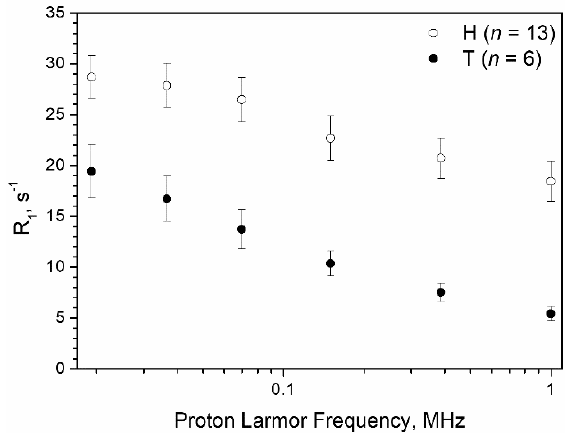
Figure 2. Comparison between typical R 1 NMRD profiles of healthy specimens (H, n = 13) and tumour samples (T, n = 6). Error bars represent the SD.